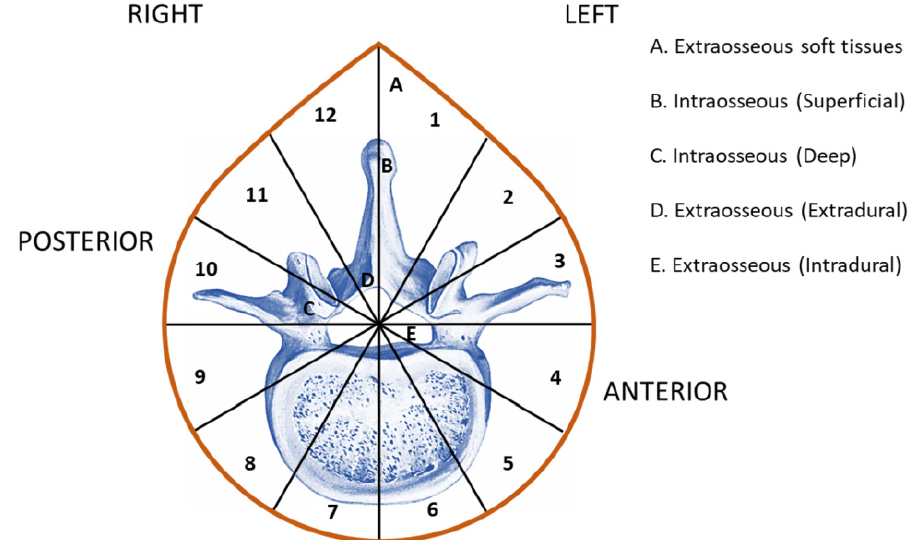
Figure 1. The Weinstein–Boriani–Biagini classification of spinal tumors. The location of the lesion is described using the 12 radiating regions (1–12) and 5 concentric layers (A–E), with layers D and E representing epidural and intradural involvement, respectively.